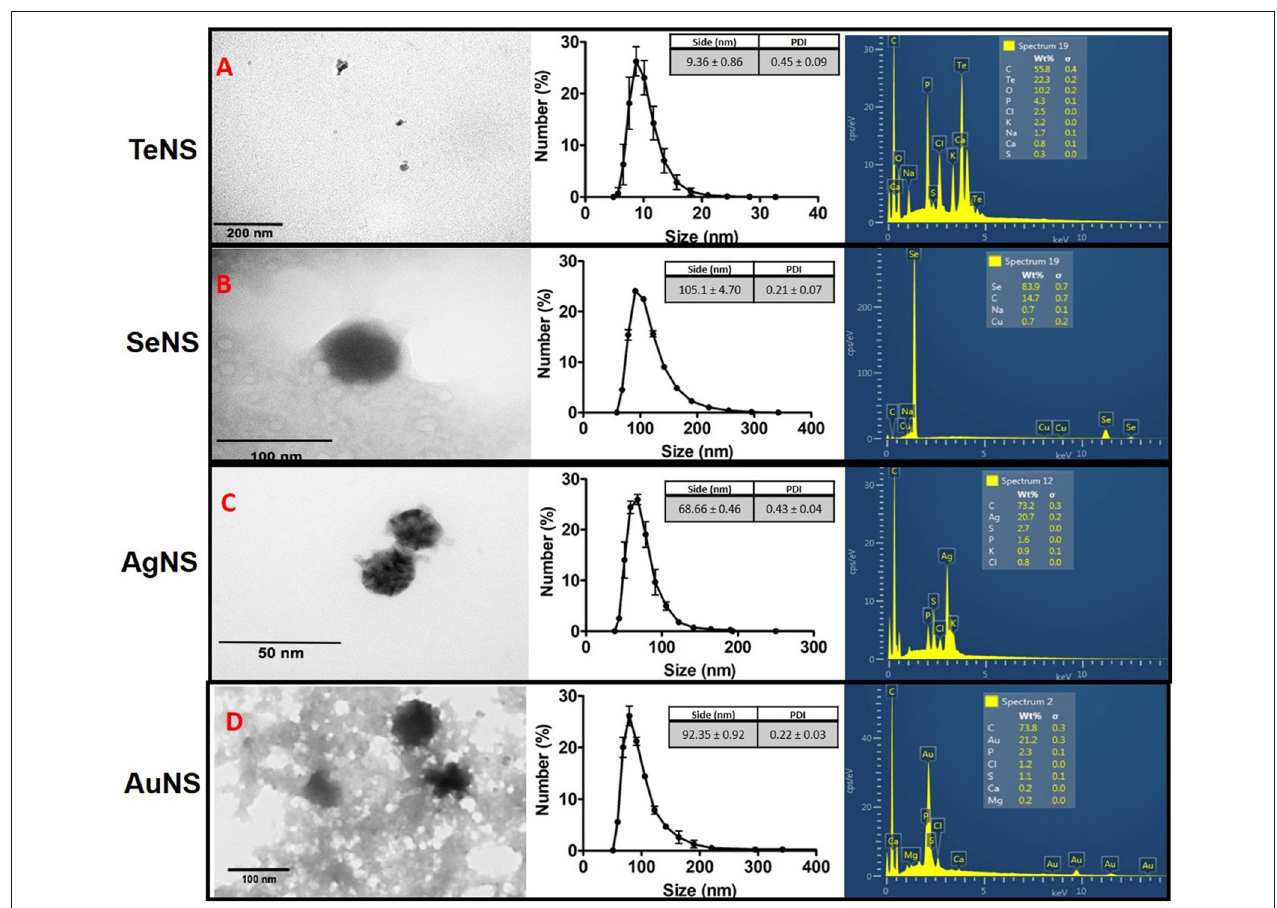
FIGURE 5 | Characterization of in vitro synthesized NSs. Electron micrographs (left), dynamic light scattering (middle), and EDS (right) of NS synthetized by: MF09 – TeNS – (A) ; MF02 – SeNS – (B) ; MF03 – AgNS – (C) ; MF09 – AuNS – (D) . Data represent the average of 3 independent trials ± SD.